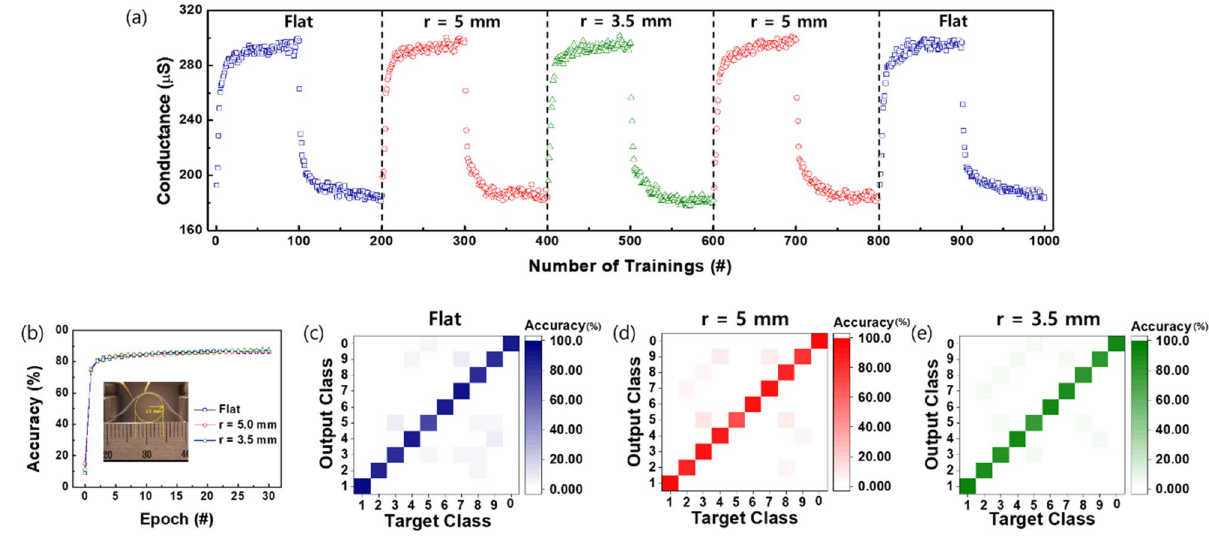
Figure 7. ( a ) Potentiation and depression characteristics corresponding to consecutive pulse trainings against mechanical stress from a flat state to 3.5-mm bending state. ( b ) Comparison of the recognition accuracies under different mechanical stresses. ( c )-( e ) Classifications for the learning and the inference test in different bending states [( c ) flat, ( d ) r = 5 mm, and ( e ) r = 3.5 mm]. Note that the classifications were visualized by using confusion matrices (10 × 10) between the target classes (input digit) and the output classes (learning